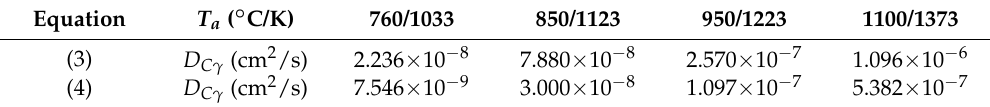
Table 1. Carbon diffusion coefficients in austenite D C γ calculated using Equations (1) and (2).